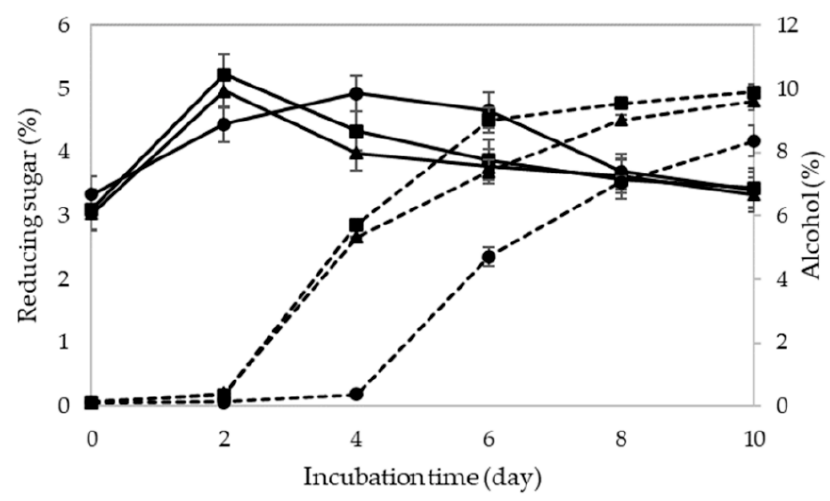
Figure 1. Total reducing sugar (solid line) and alcohol content (dash line) of pineapple juice and water at a ratio of 2:1 ( █ ), 1:1 ( ▲ ), and 1:2 ( ● ) during wine fermentation. water at a ratio of 2:1 ( (cid:4) ), 1:1 ( (cid:78) ), and 1:2 ( • ) during wine